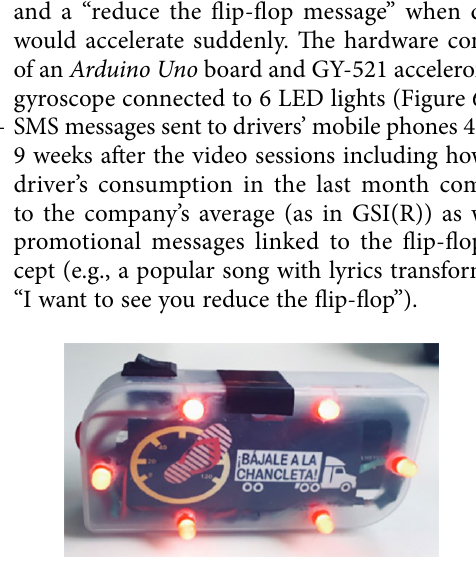
Figure 6. The LightBox